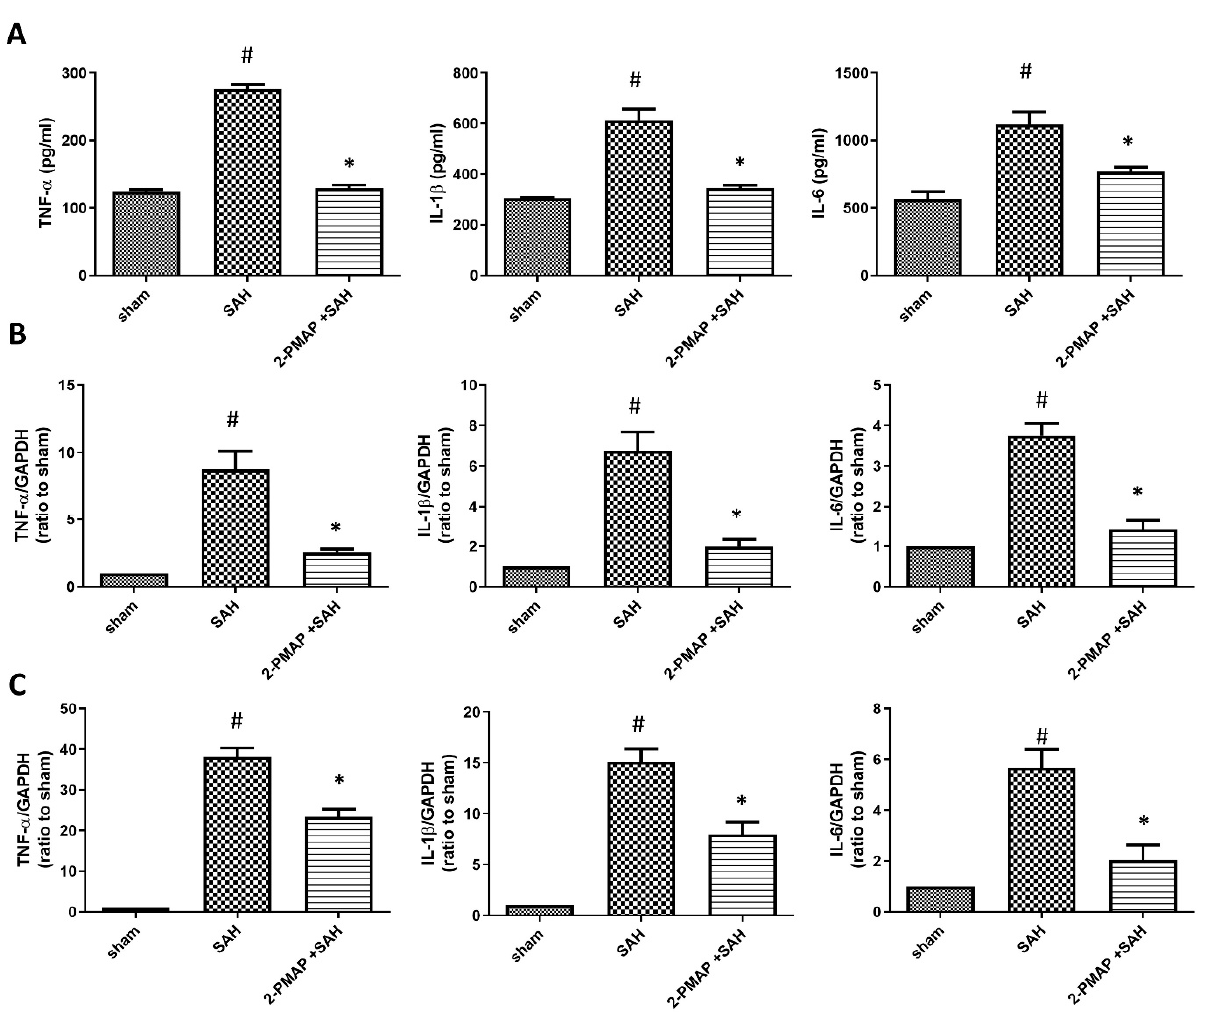
Figure 3. 2-PMAP decreased inflammatory cytokines in SAH rats. ( A ) The inflammatory cytokines in CSF were measured by an enzyme-linked immunosorbent assay 48 h after SAH. The level of TNF α , IL-1 β and IL-6 was significantly increased after SAH, whereas 2-PMAP reversed these levels. ( B , C ) qRT-PCR was used to test the relative expression of inflammatory cytokines in the BA and brain tissues. The level of TNF α , IL-1 β and IL-6 in ( B ) the BA and ( C ) brain tissues was significantly increased after SAH, whereas 2-PMAP also reduced these levels. Data are shown as mean ± SD ( n = 6 for each group); *, p < 0.05, significantly different from the SAH group. #, p < 0.05, significantly different from the sham